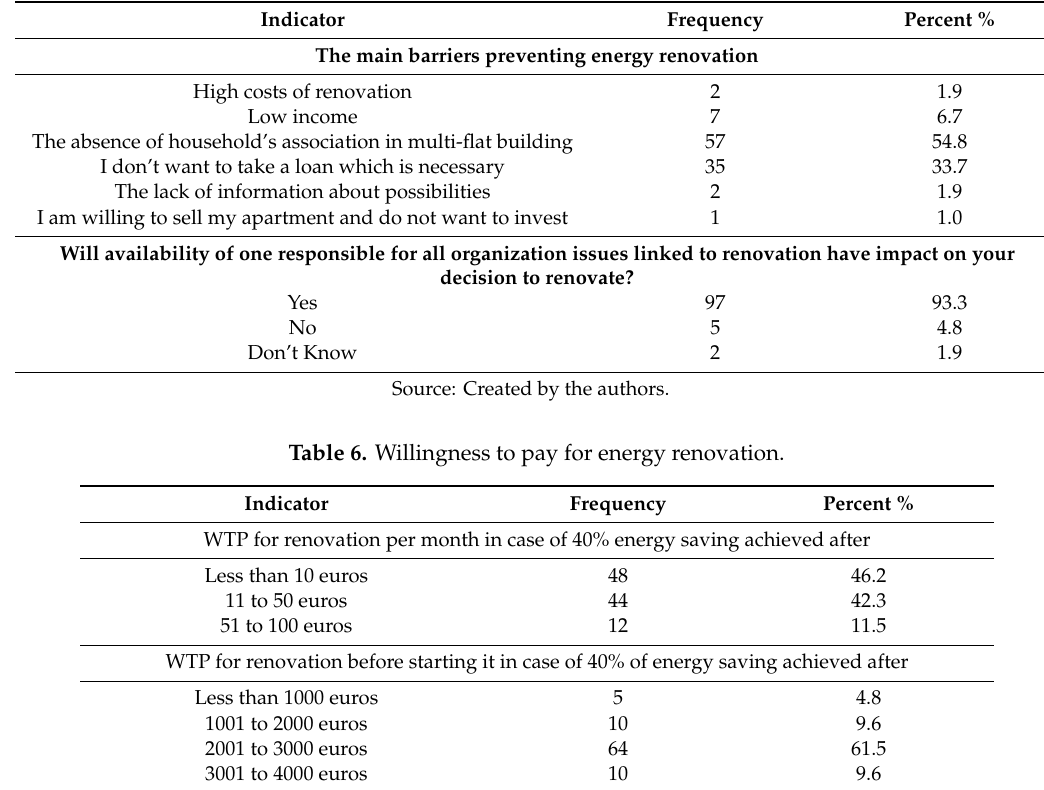
Table 5. Barriers of energy renovation.